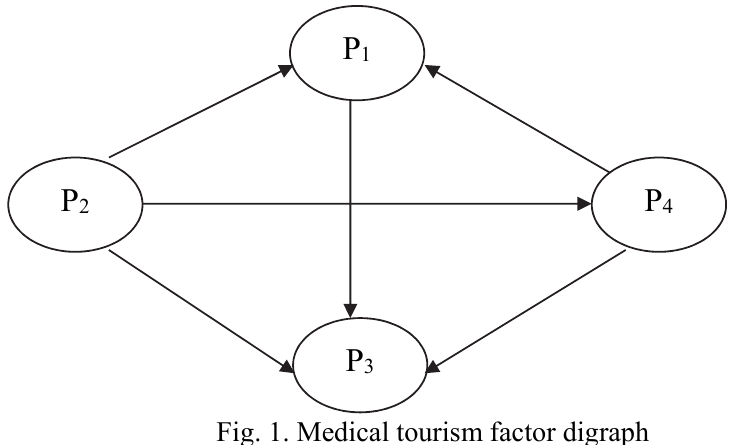
Fig. 1. Medical tourism factor